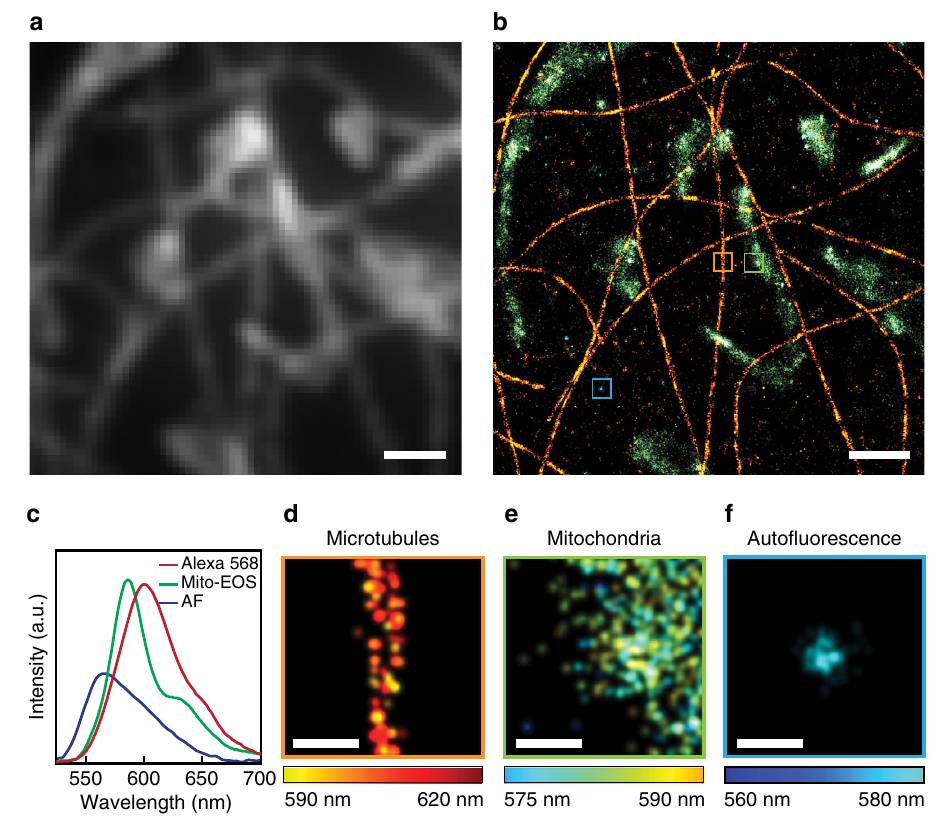
Figure 4 | Multi-labelled SPLM imaging. ( a ) Wide-field fluorescence image of a dual-stained COS-7 cell. ( b ) The corresponding SPLM image. Scale bars, 1 m m ( a , b ). ( c ) Fluorescence emission spectra of Alexa Fluor 568, Mito-EOS 4b and the distinct emission spectrum from the background. The three colours represent the spectral peak wavelengths of different molecules. Magnified views of the regions inside the coloured squares show ( d ) a single microtubule, ( e ) the edge of mitochondria and ( f ) a spot with autofluorescence emission. Scale bars, 100nm ( d – f